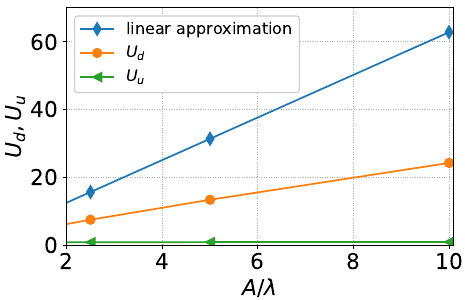
Figure 5. Dependence of U d (orange line) and U u (green line) on the ratio A / λ ∈ ( 2,10 ) . The blue line shows the linear approximation